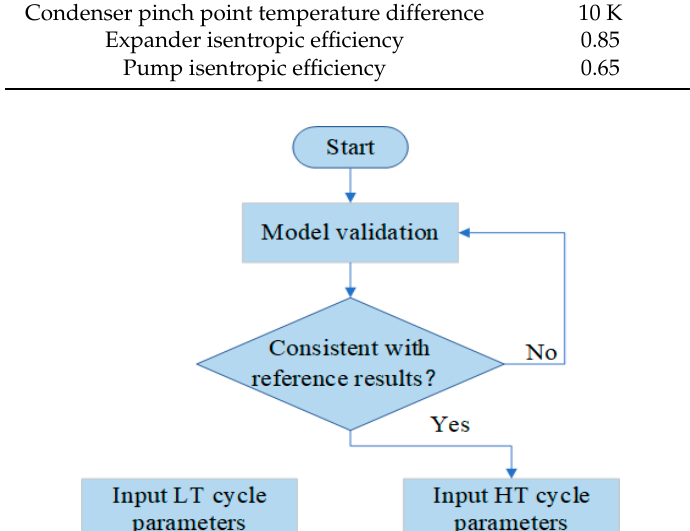
Table 4. Comparison of TLC results between the present computation and reference [27]. Parameters